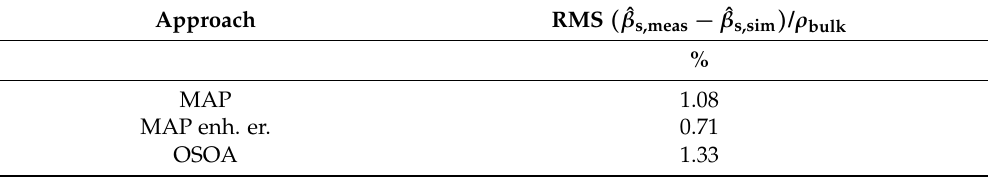
Figure 13. Measurement-based model validation for different ECT-based estimation algorithms. Table 4. Quantitative comparison between the average trend of the simulated estimates ˆ β s,sim and the estimates ˆ β s,mean of the measurement experiments (see Figure 13) for different ECT-based estimation